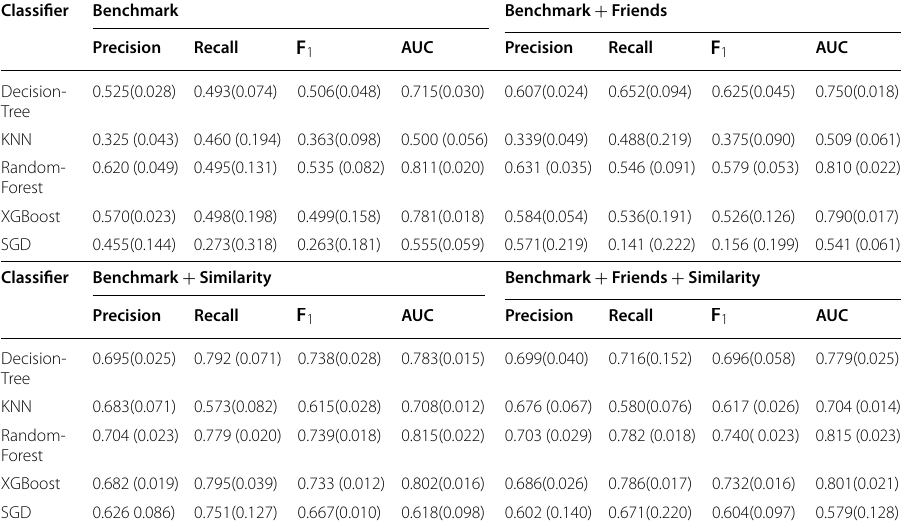
Table 4 Performance, mean and (standard deviation), of churn prediction models for the four feature groups using the 5-day